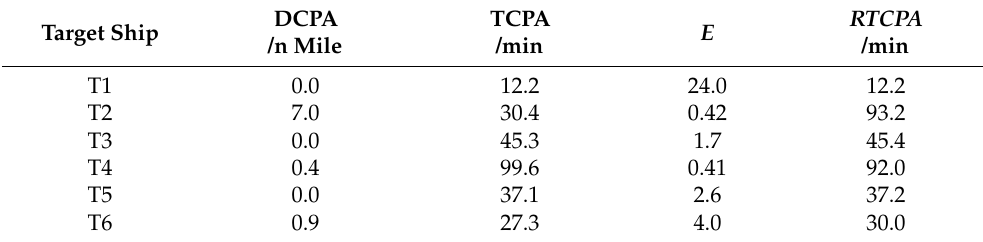
Table 3. CCI of target